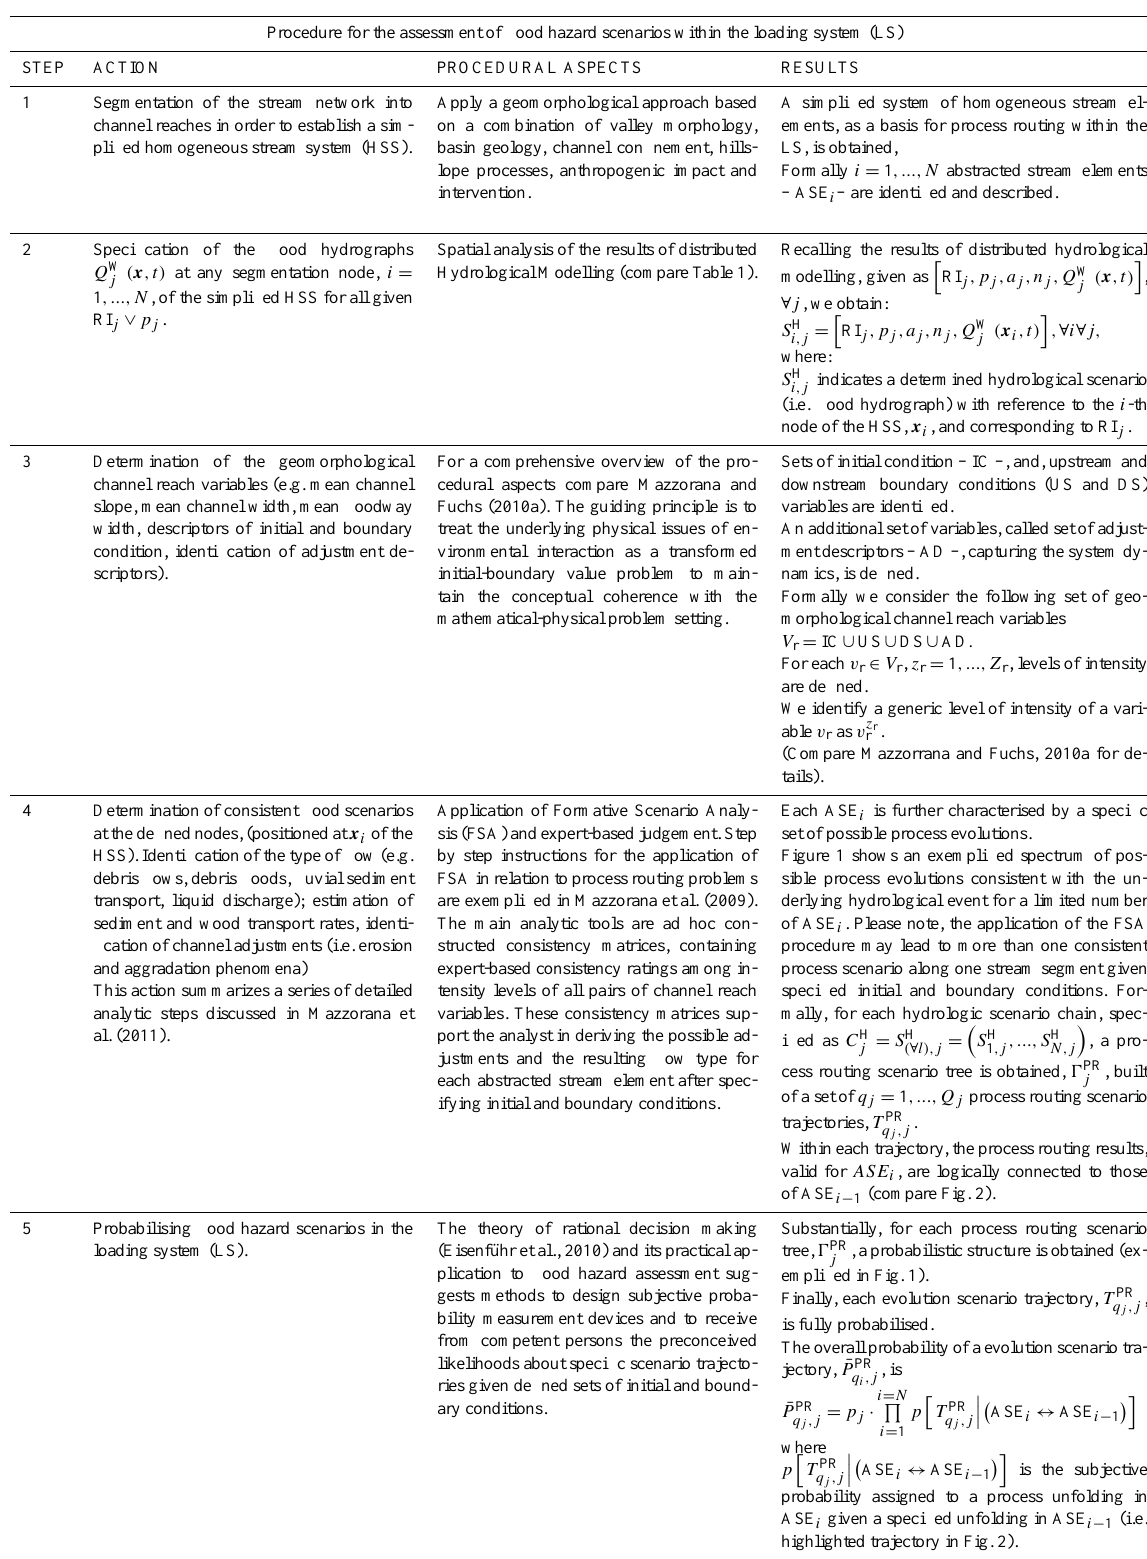
Table 2. Main process analysis steps in the loading system